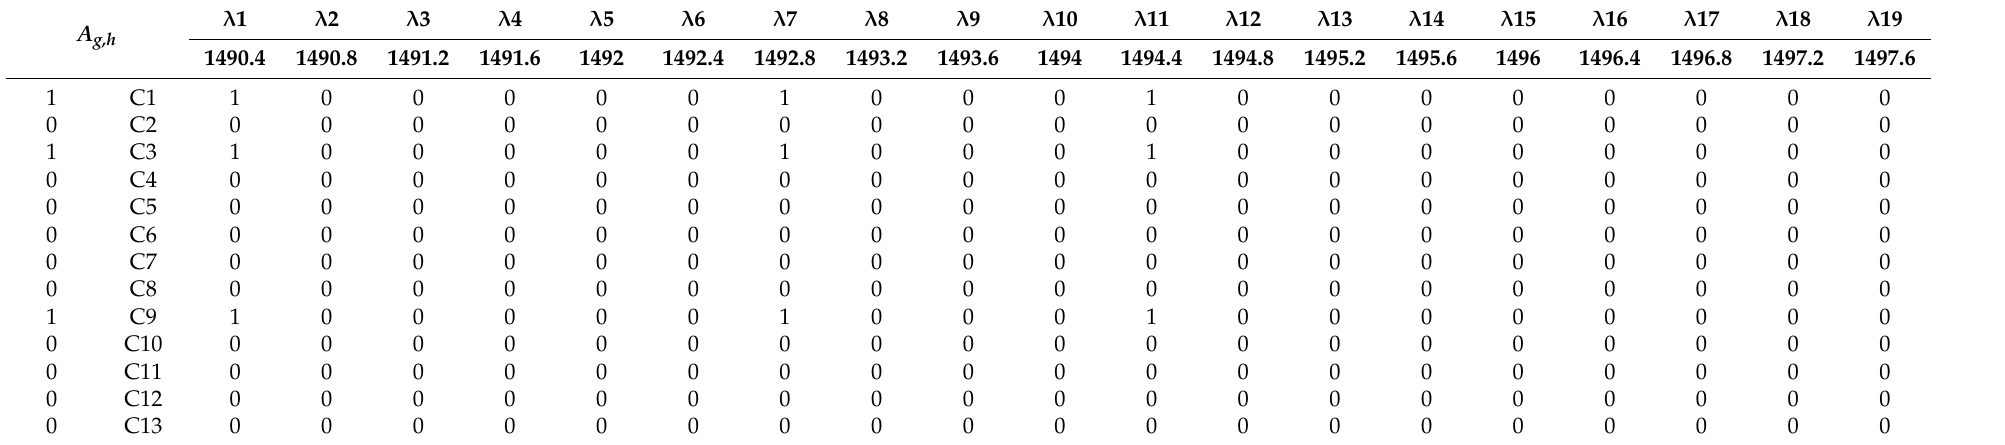
Table 5. Wavelength and star coupler allocation for single